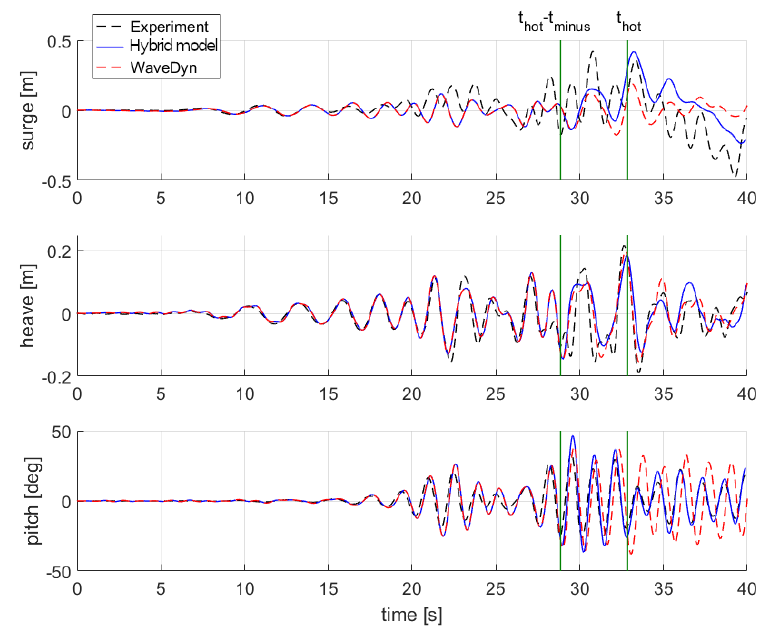
Figure 16. Comparison of motion response time-series between experiment and numerical models prediction where the hybrid model is triggered by WaveDyn’s validity limit. | indicate hot-start time ( t hot ) and when coupling starts ( t hot − t minus